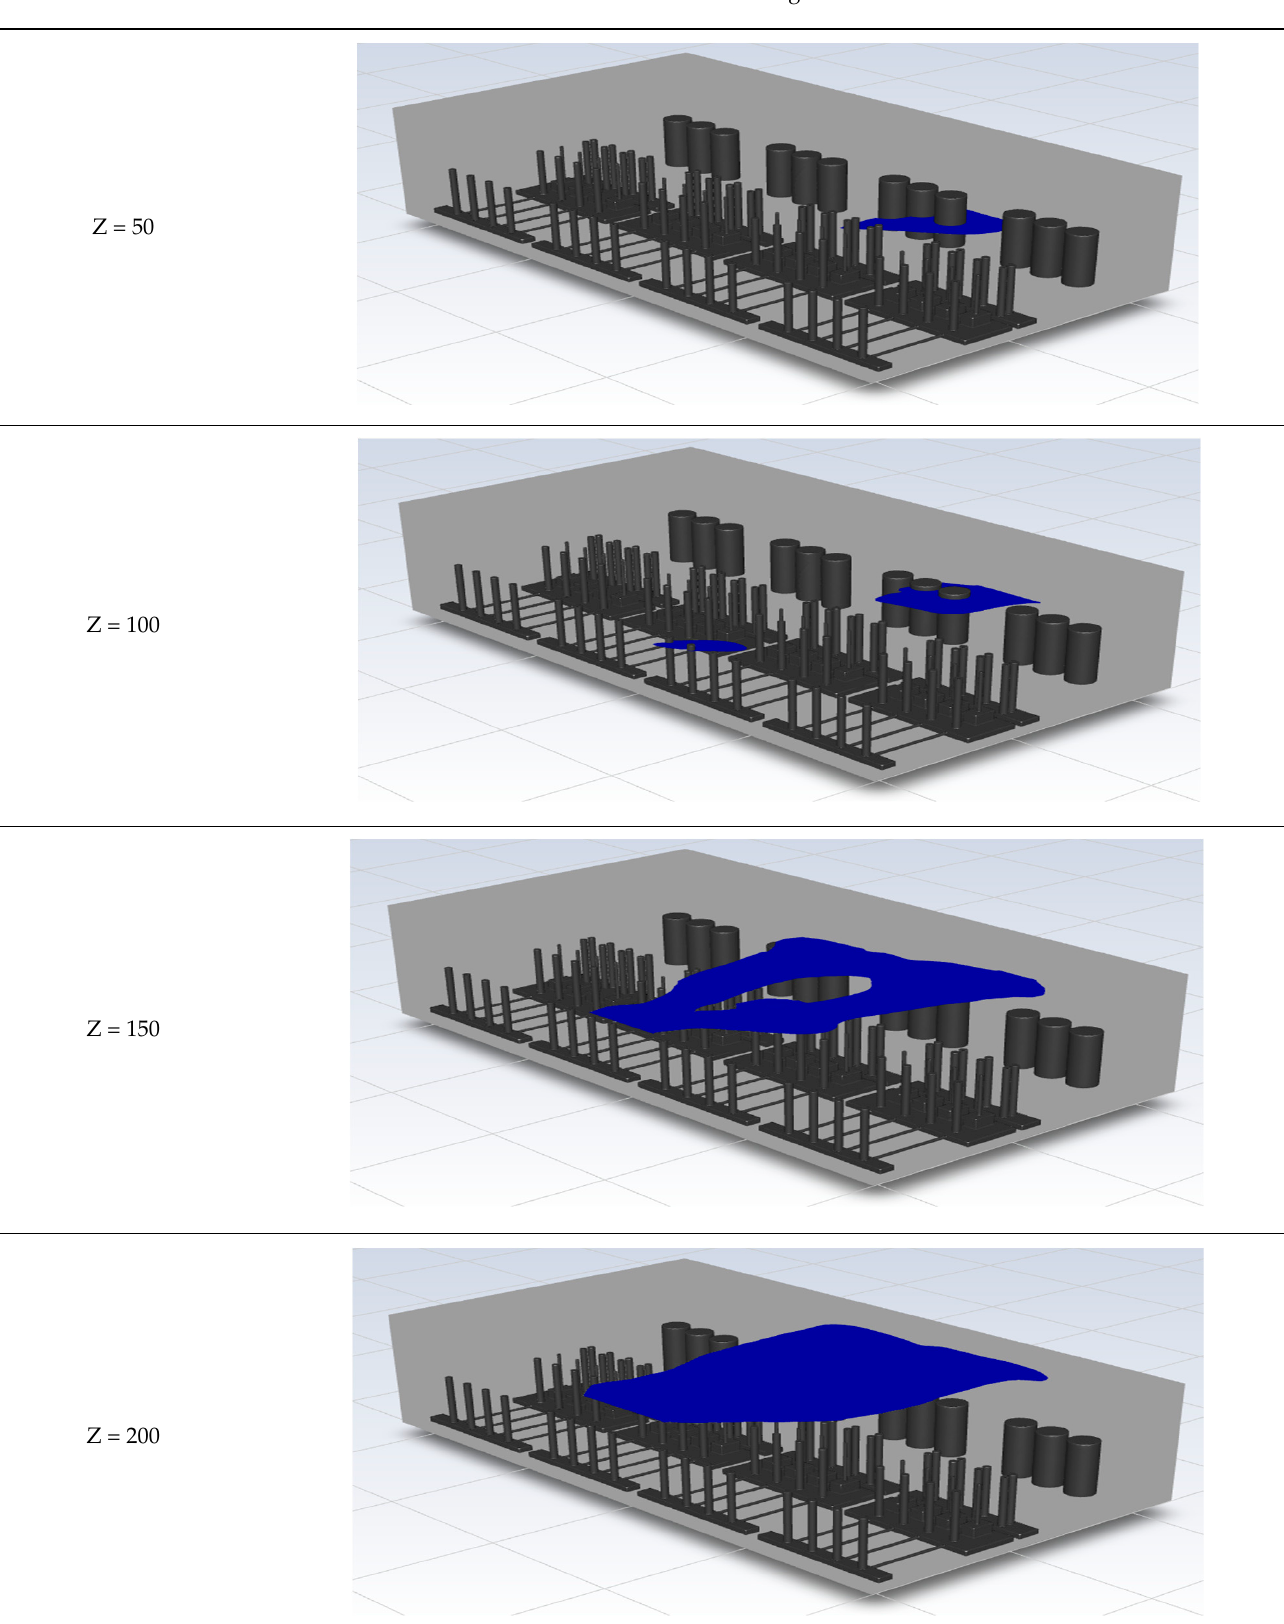
Table 10. Distribution of concentrations exceeding 25% of the LFL on the XY